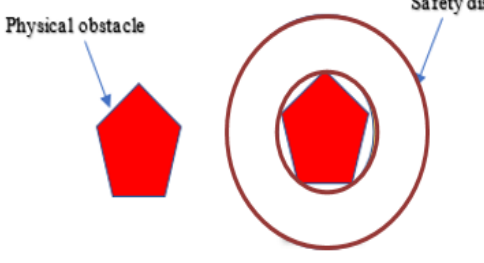
Fig. 1. Increase the Size of The